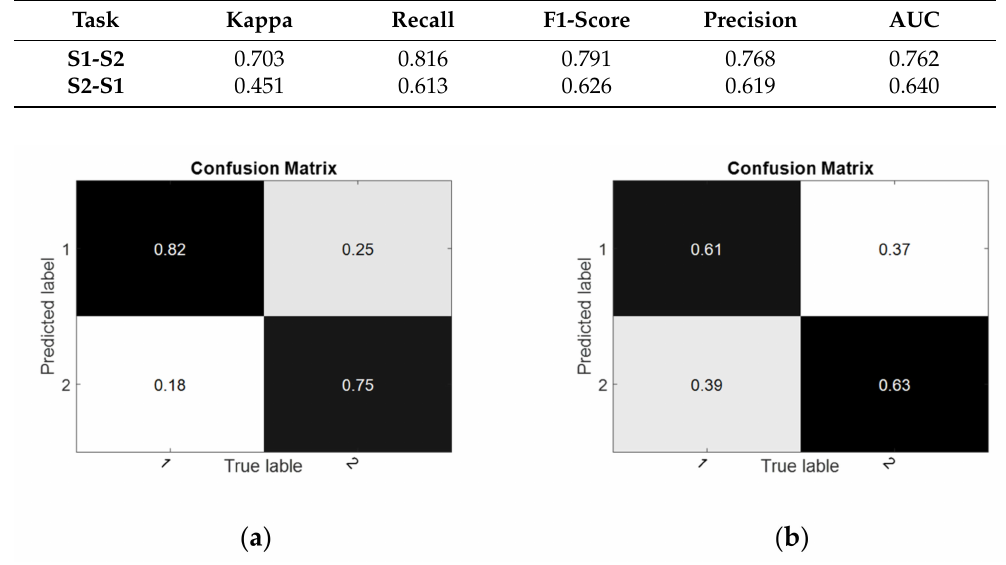
Figure 12. The results of different classifiers in the cross-subject experiment. Table 5. The performance matrices of RF in the cross-subject experiments.